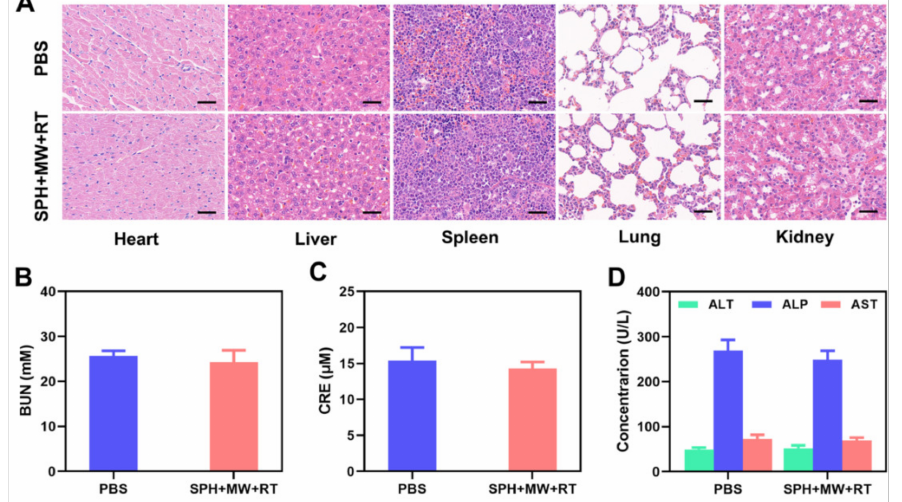
Figure 5. ( A ) H&E-stained images of the mice’s major organs, including the heart, lungs, liver, kidneys, and spleen, after exposure to various therapies 16 days post-injection (n = 5). ( B ) Kidney function markers: BUN, ( C ) CRE; ( D ) liver function indicators: ALT, AST, and ALP, following different treatments (n = 5). Scale bars: 100 µ